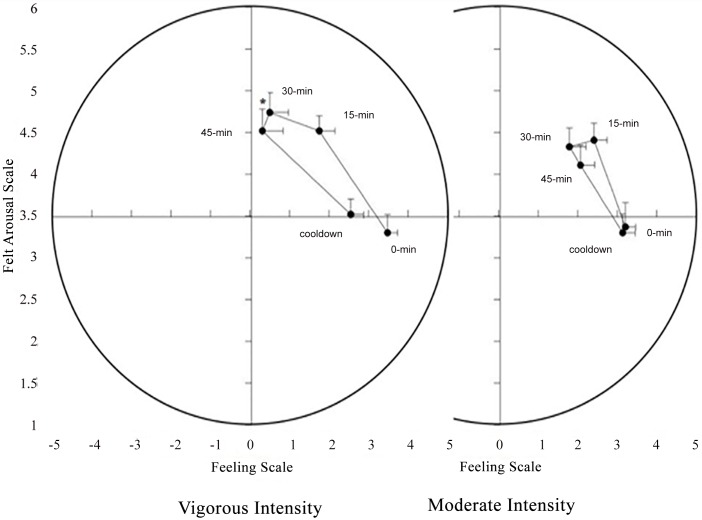
Temporal dynamics of the affective valence and perceived activation responses to the two exercise intensity trials.Data are shown as means ± standard error. * p < 0.01, moderate-exercise intensity significantly different from vigorous-exercise intensity.